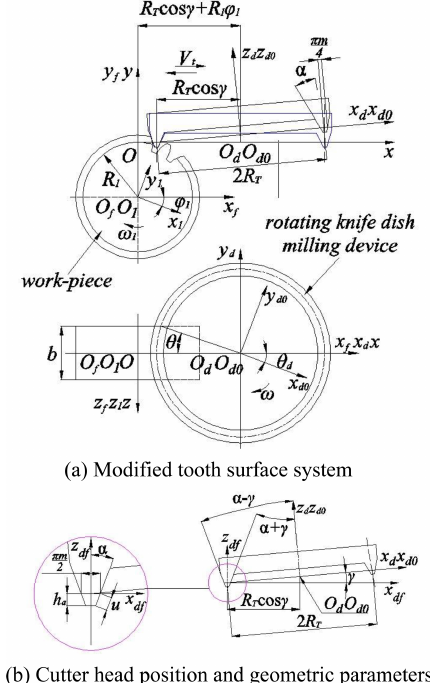
Figure 5. Machining coordinate system of double-edged milling with large cutter